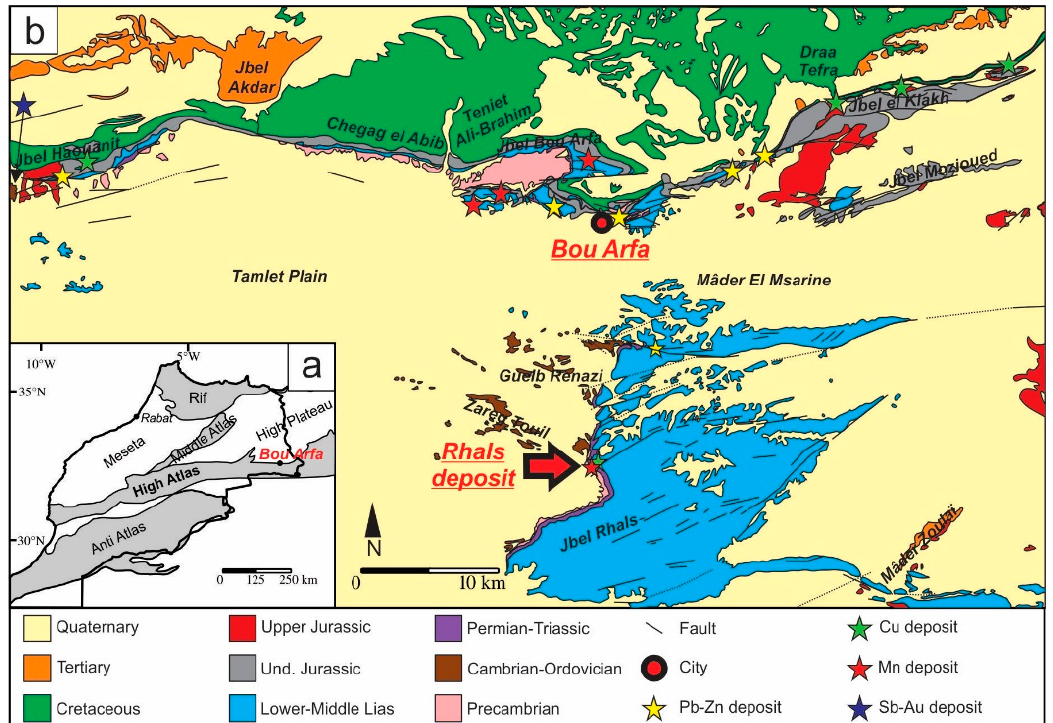
Figure 1. ( a ) Simplified geologic map of parts of Morocco and location of Bou Arfa; ( b ) Synthetic geologic map of the Bou Arfa region generalized according to the ages of units and showing the location of the Jbel Rhals ore deposit (modified from [4]).